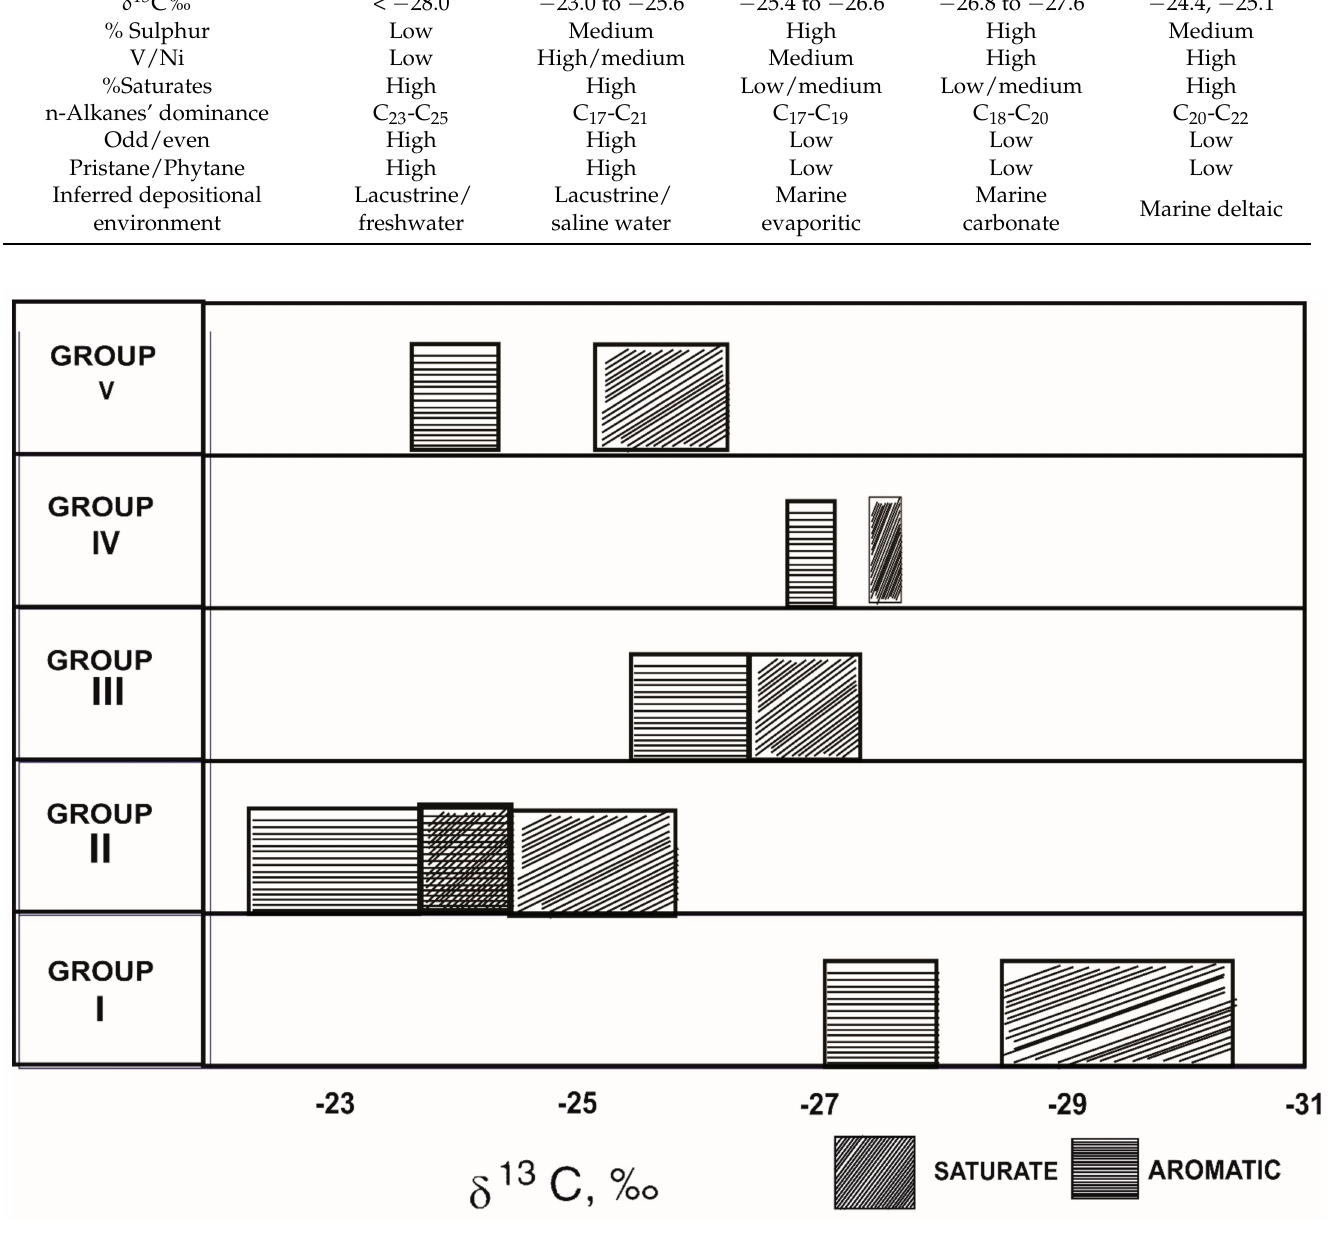
Figure 4. Saturate and aromatic carbon isotopic data of the crude oils from Brazil. (Reproduced from [109] with permission from